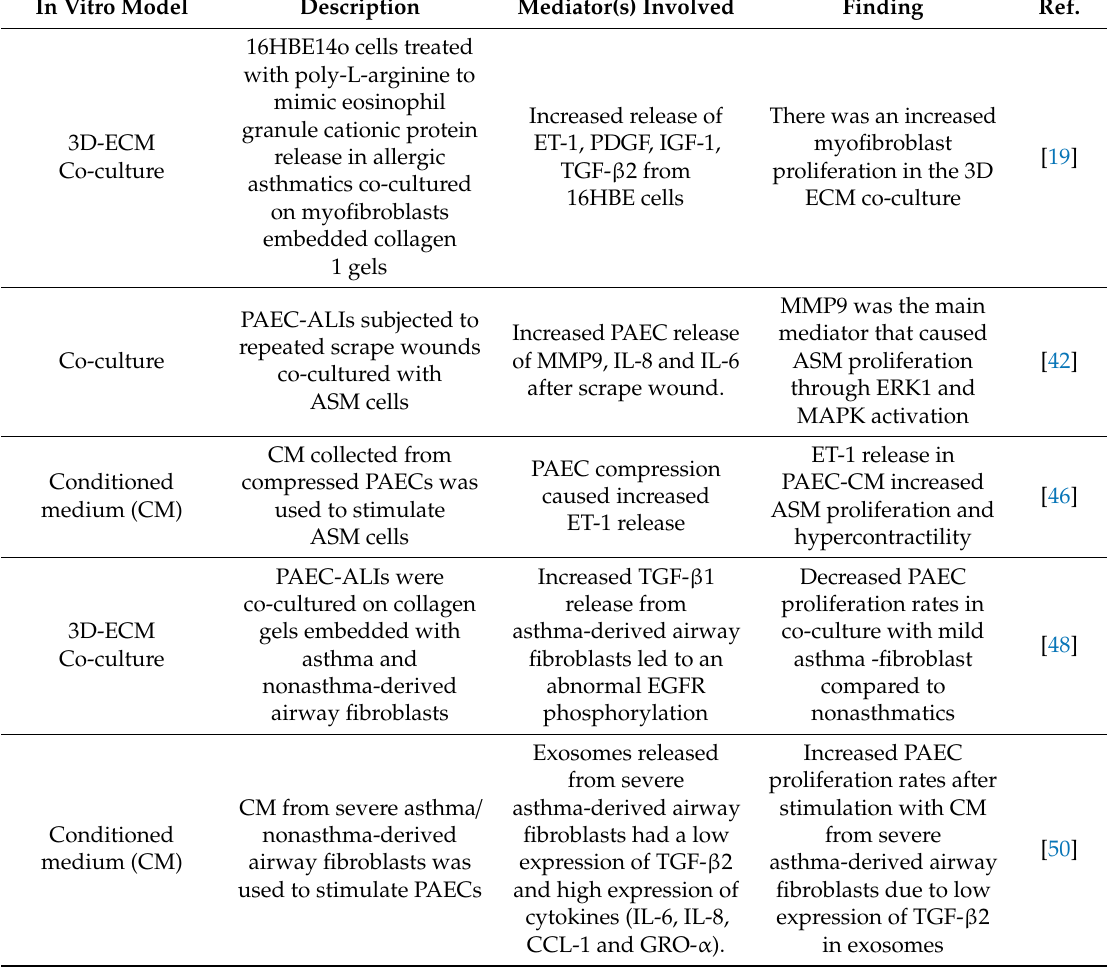
Table 2. Summary of studies assessing cellular proliferation in asthma with EMTU